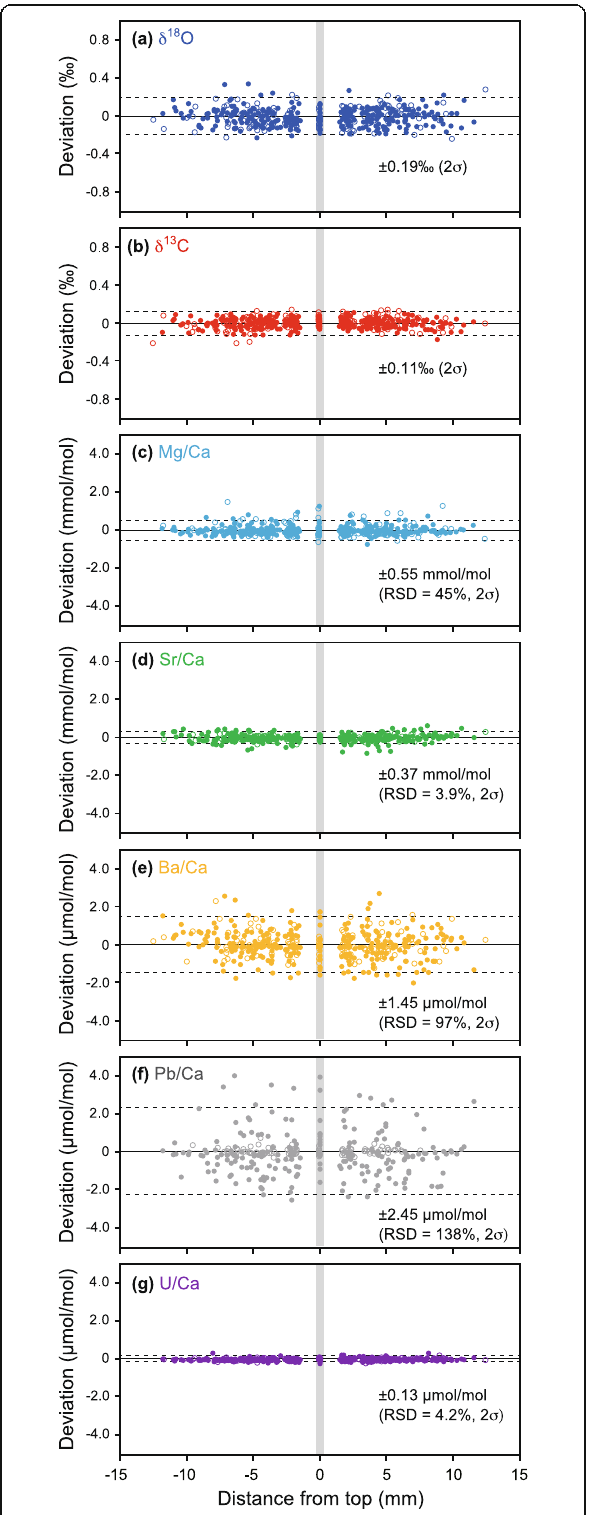
Fig. 6 Within-skeleton variations in a δ 18 O and b δ 13 C values and c – g elements/Ca ratios of sclerosponges. Deviations to the average in an individual sample are shown. Horizontal lines and dotted lines respectively represent zero and standard deviation (2 σ